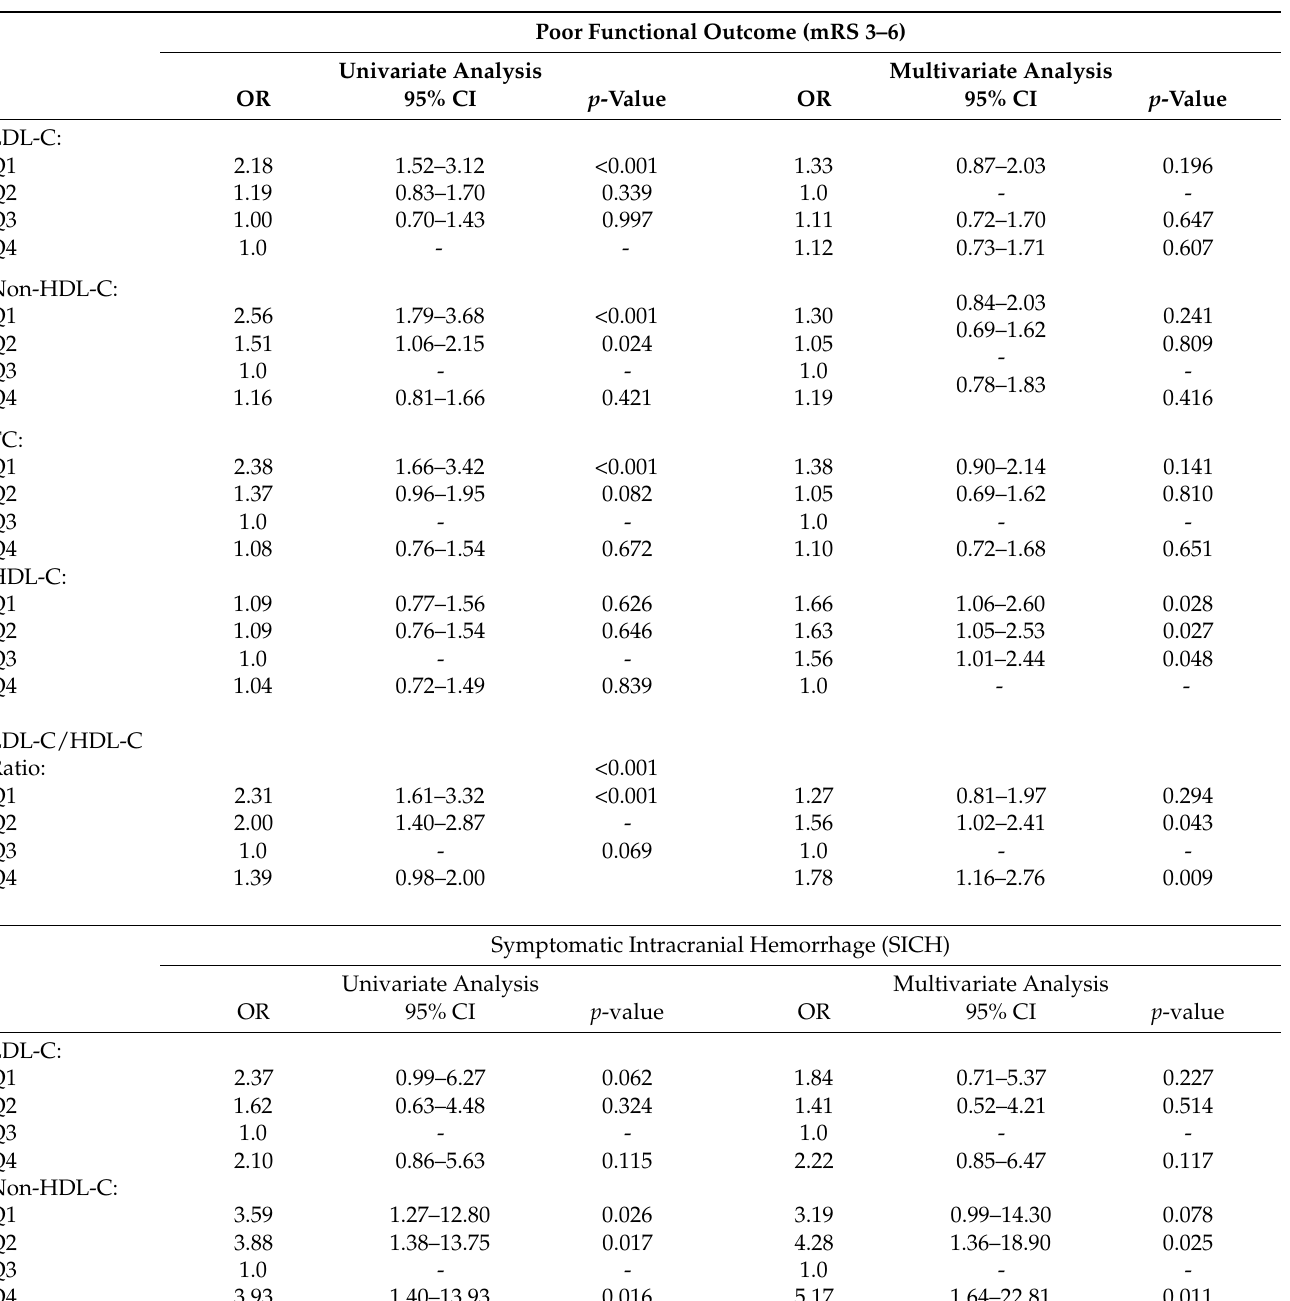
Table 4. Association of Lipid Parameters with Poor Functional Outcome, SICH and